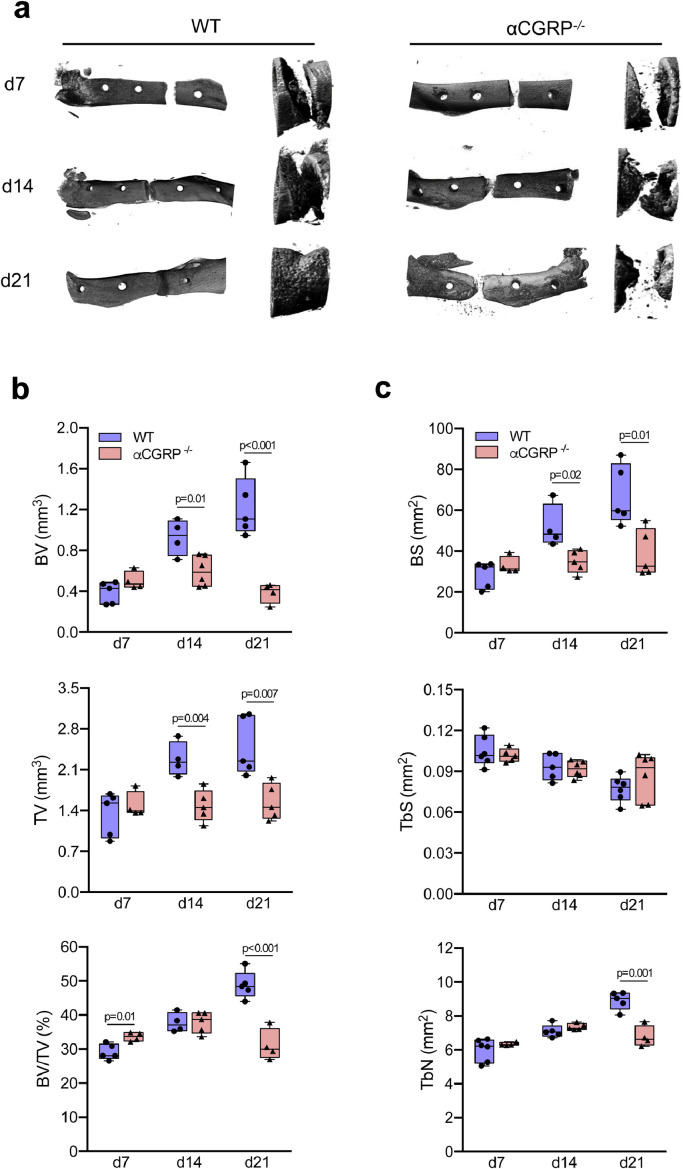
Deficiency in αCGRP results in the failure of bone regeneration. (a) Representative µCT images (left column= longitudinal overview; right column = longitudinal magnification) of the callus region in the femur of WT and αCGRP-deficient mice at the indicated time points. (b) Quantitative analysis of µCT images in mice of both genotypes at the same time points. BV = total callus bone volume, TV = total tissue volume, BV/TV = bone volume vs. tissue volume. (c) Quantitative analysis of µCT images in the same samples. BS = bone surface, TbS = trabecular surface, TbN = trabecular numbers. For (b) and (c), the different timepoints were evaluated independently and compared by unpaired student's t-test. n = 4–6 as indicated per group and time point. Box plots represent median with minimum and maximum whiskers.